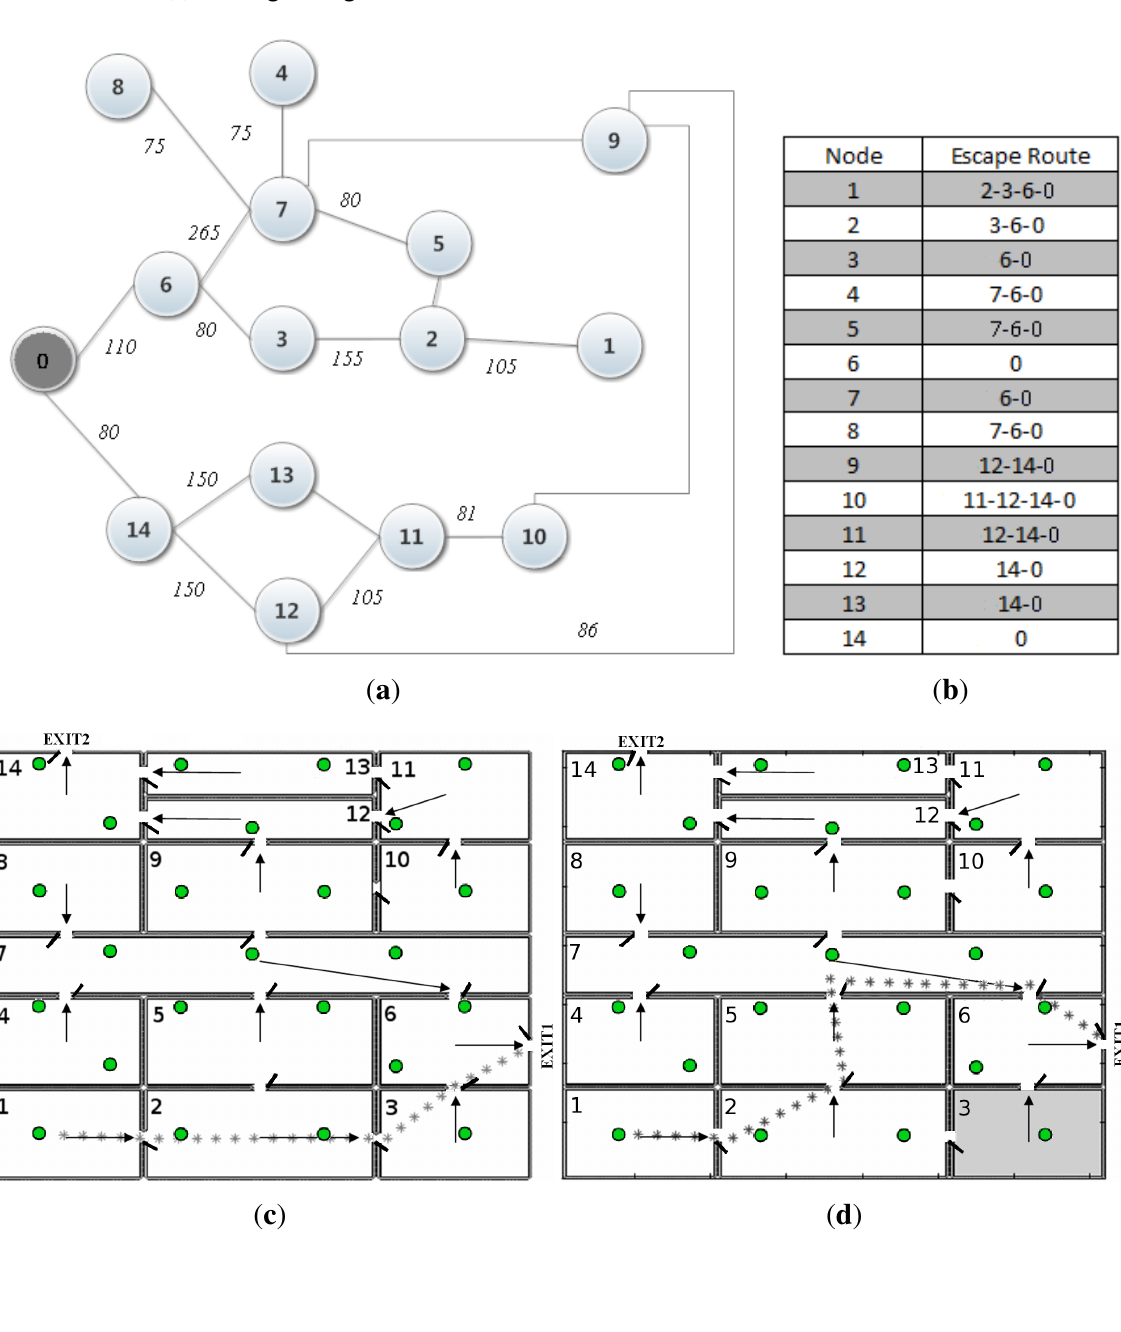
; ( c – e ) maps with resulting escape paths at times 1 , t and t 1 2 3